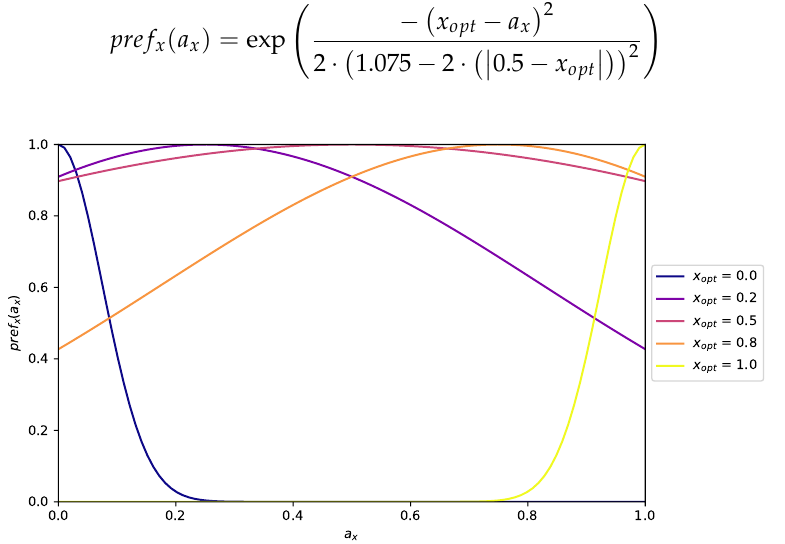
Figure 2. Plots showing different preference functions for different optimal